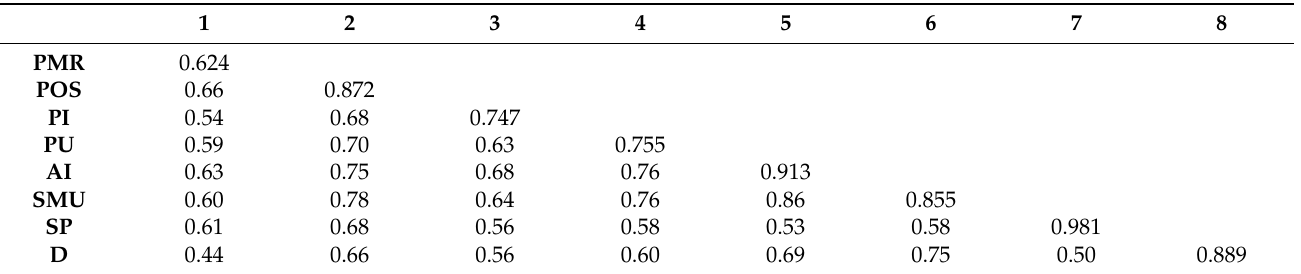
Table 8. Correlations between the